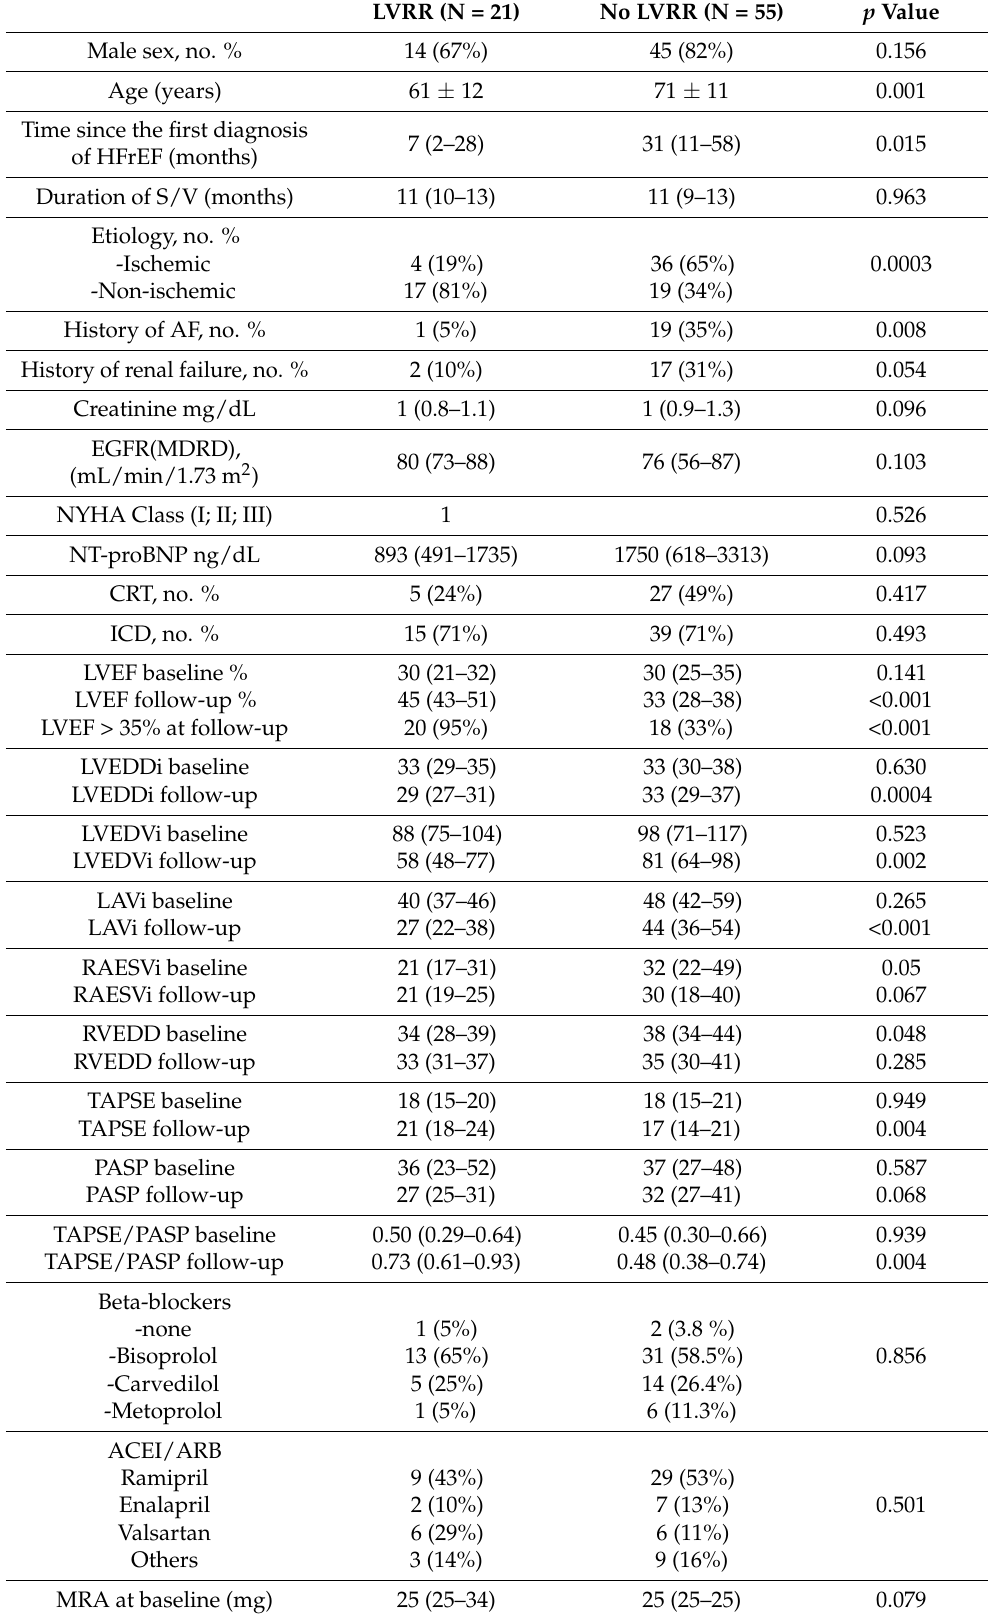
Table 3. Comparison between clinical and echocardiographic parameters in patients with and without positive left ventricular cardiac